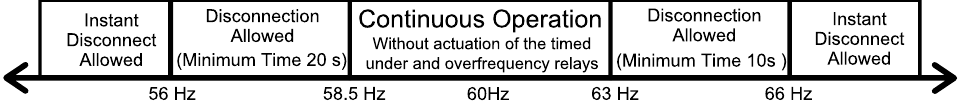
Figure A2. Nonrated frequency regime for hydropower units [38].